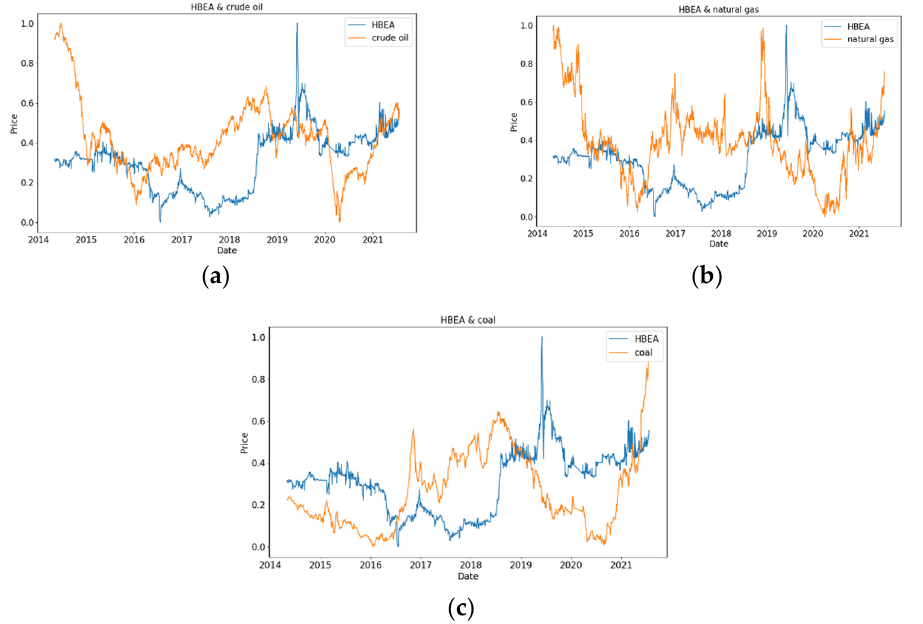
Figure 3. HBEA compared with the energy analysis. ( a ) HBEA and crude oil; ( b ) HBEA and natural gas; ( c ) HBEA and coal.